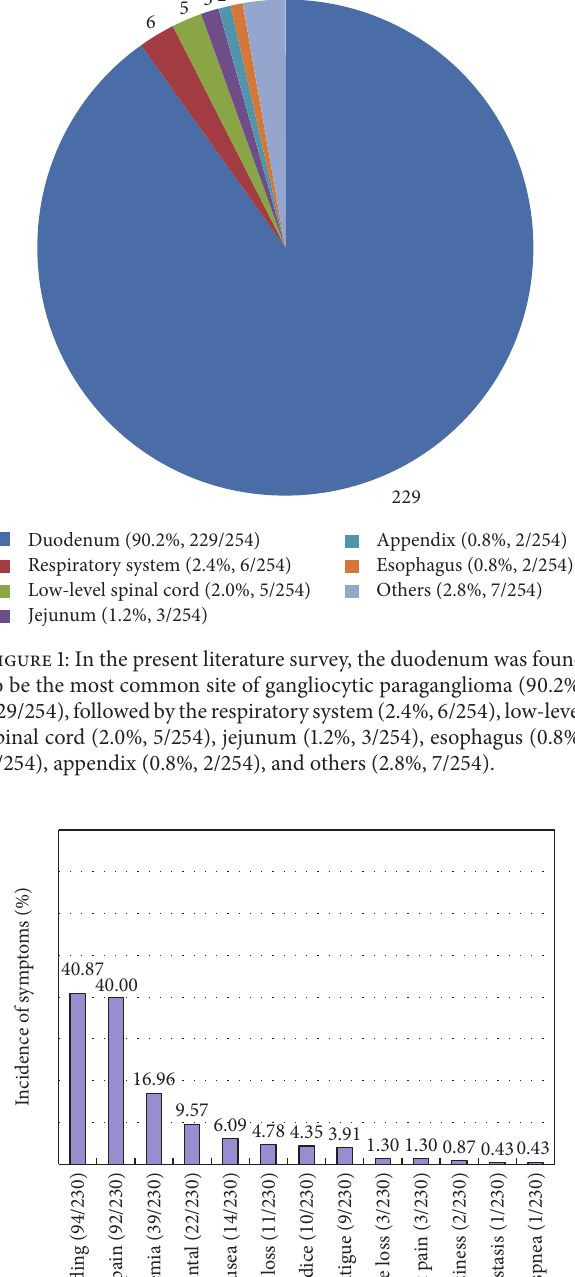
Figure 2: In the present literature survey, gastrointestinal bleeding was the most common symptom of gangliocytic paraganglioma (GP; 40.9%, 94/230), followed by abdominal pain (40.0%, 92/230), anemia (17.0%, 39/230), incidental findings (9.6%, 22/230), nausea (6.1%, 14/230), weight loss (4.8%, 11/230), and jaundice (4.4%, 10/230). It has been largely accepted that gastrointestinal bleeding and abdominal pain commonly occur in patients with GP; however, our survey revealed that obstructive jaundice is less common in patients with GP, although GP commonly occurs in the second part of the